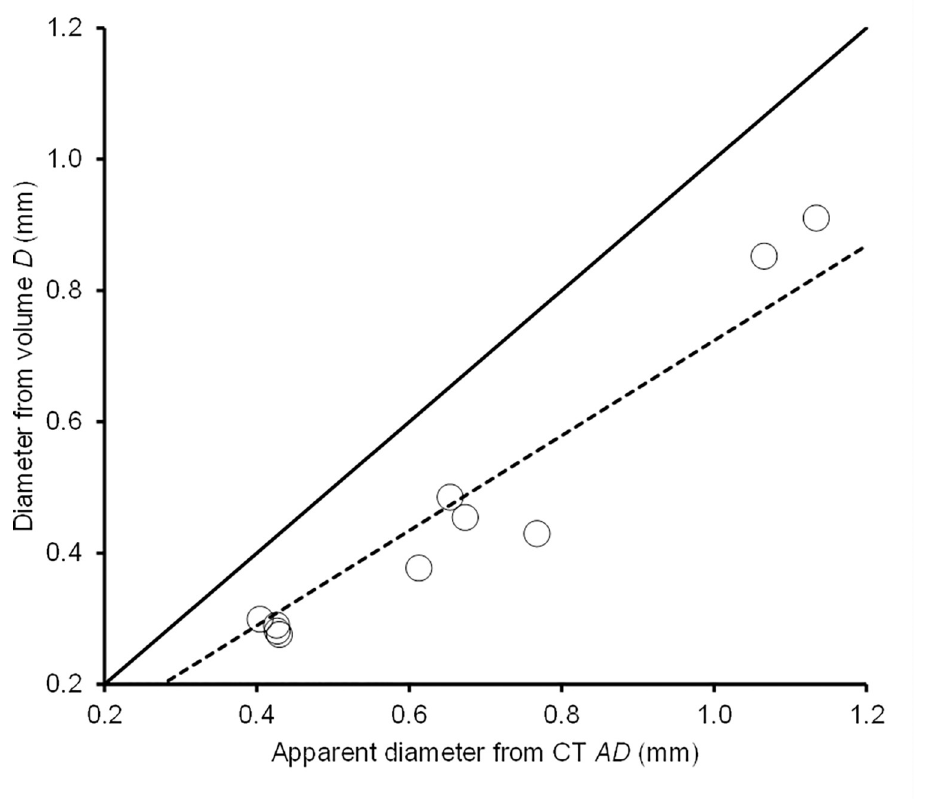
Fig 1. Known diameter of lead spheres in relation to their apparent size on a micro-CT scan. Mean diameter D (mm) of ten batches of lead spheres injected into domestic fowl carcasses, derived from their measured mean mass and estimated volume, in relation to the apparent mean diameter AD of the same batches of injected spheres derived from their volume and estimated from the number of radio-dense CT voxels per sphere. The solid line shows the relationship expected if the two diameter estimates were equal. The dashed line shows the regression of D on AD constrained through the origin, D = 0.724 AD